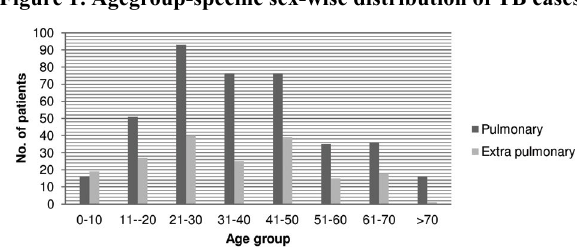
Figure 3: Extrapulmonary TB cases according to the site